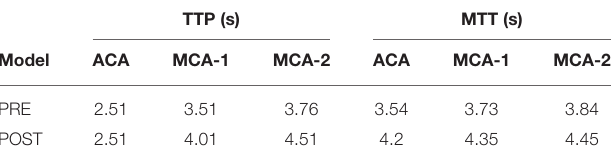
TABLE 5 | The perfusion parameters at pre- and